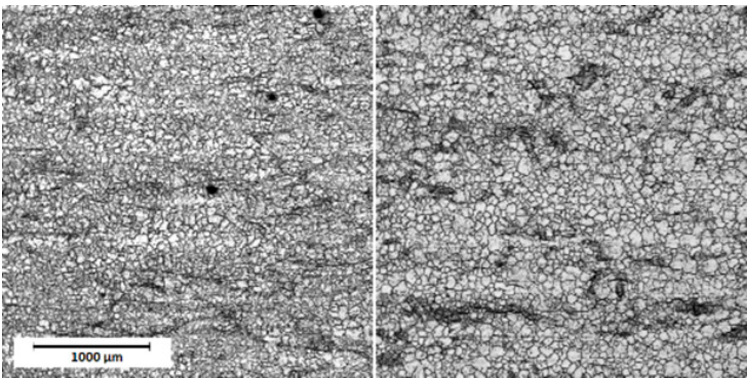
Figure 1. The confocal microscopy images of the untreated AISI 304 ( left ; 304_RAW) and 316 ( right ; 316_RAW) stainless steel plates.